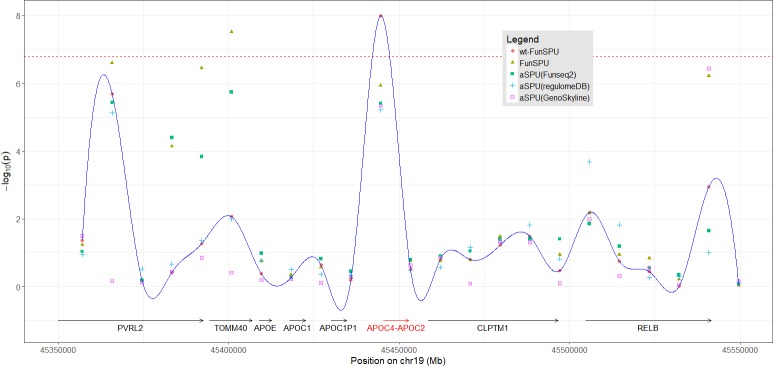
Association test results for LDL at the locus around gene APOC4-APOC2.The round points and the trace show the results from the globally weighted wtFunSPU test. Other points correspond to the results of FunSPU and single annotation-based aSPU (GERP++, Funseq2, RegulomeDB, GenoSkyline), respectively. Dashed line indicates the threshold of genome-wide significance level (p < 1.56e-7).